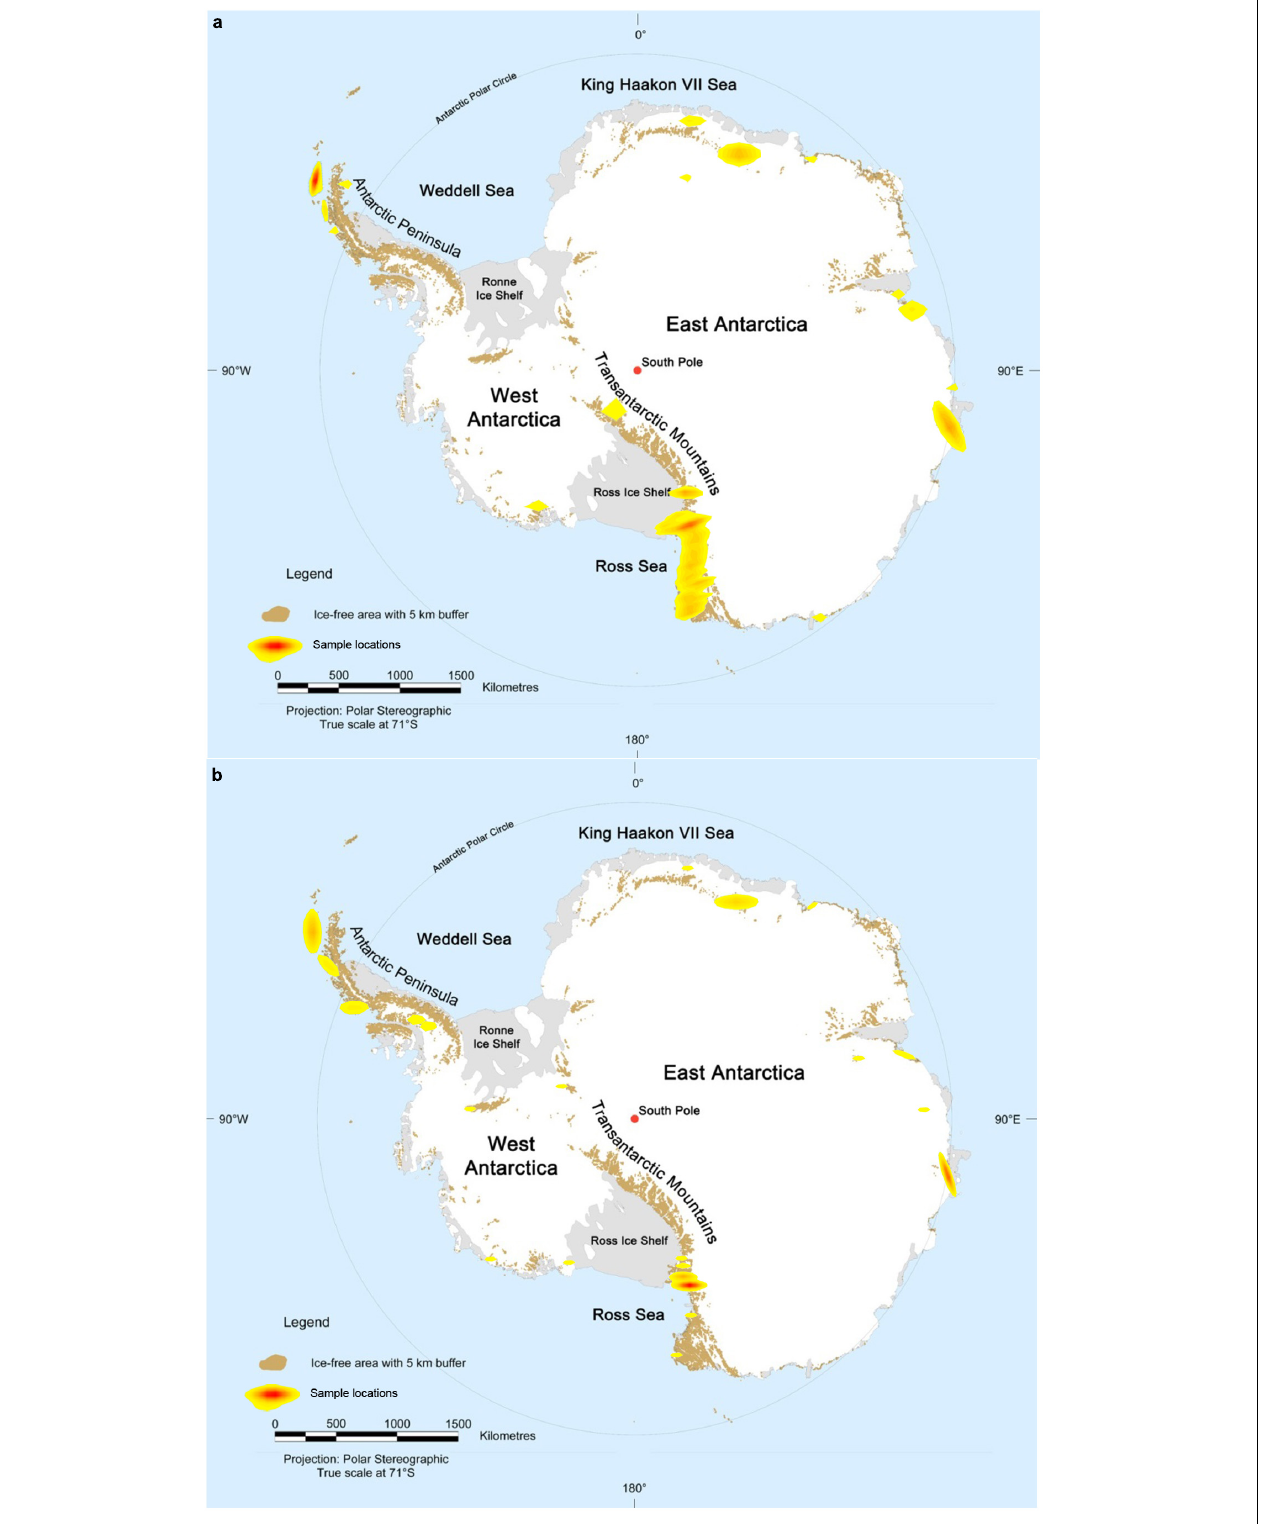
FIGURE 1 | Overview of the Antarctic continent showing ice-free regions sampled for bacterial diversity studies using (a) cultivation (84 studies, 156 samples) and (b) cultivation-independent (105 studies, 1961 samples) surveys. Ice-free areas are highlighted in brown. Sampling sites are shown in a color gradient from yellow to red with increasing number of sample locations. Map modified from map no. 13766 of the Australian Antarctic Data Centre (2010).